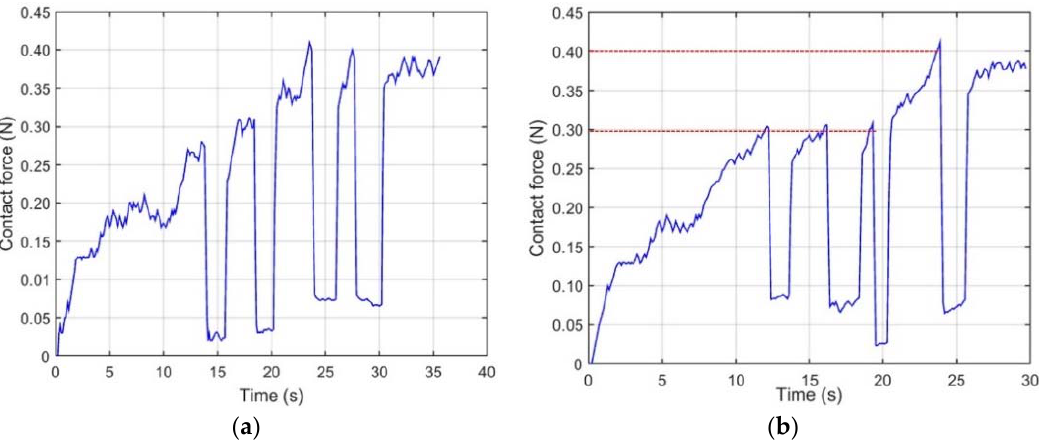
Figure 19. The resistance force trajectories in the slave side: ( a ) The resistance force trajectories under mode 1; ( b ) the resistance force trajectories under mode 2.